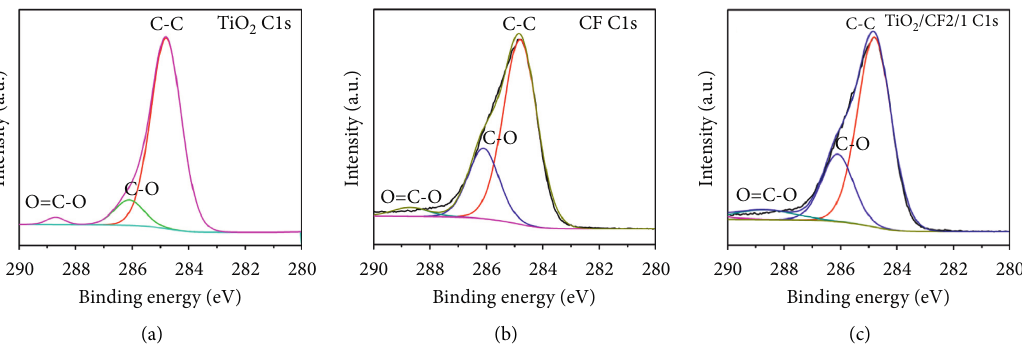
Figure 6: C 1s XPS spectra of (a) TiO